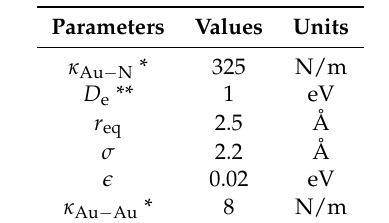
Table A1. Parameters used in the